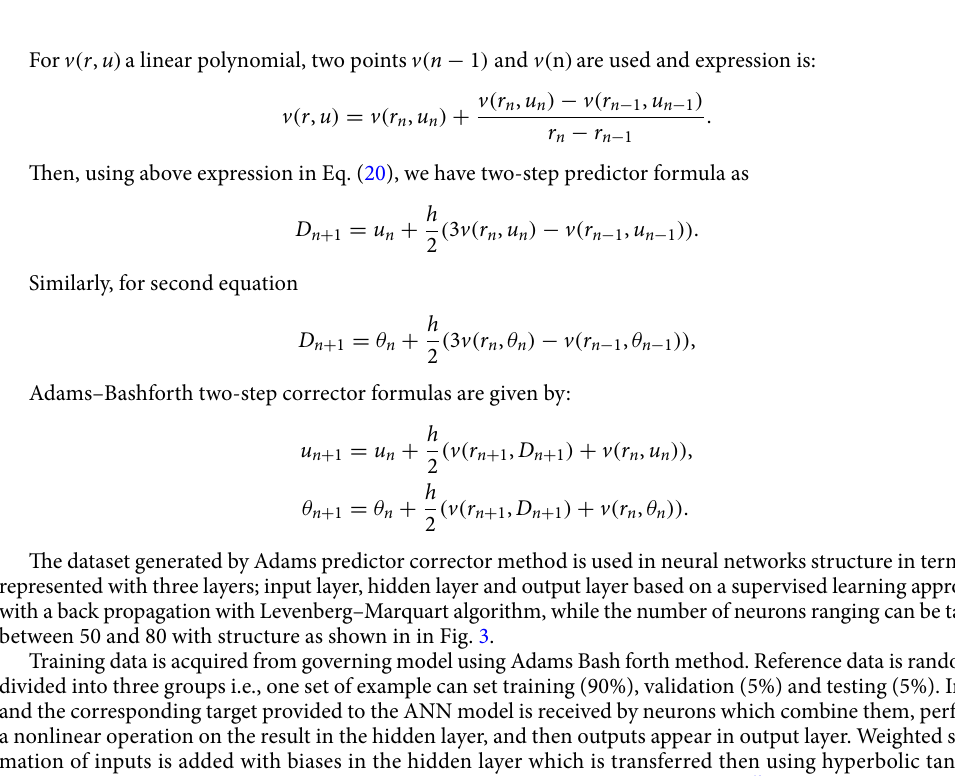
Figure 3. Neural network model for selected